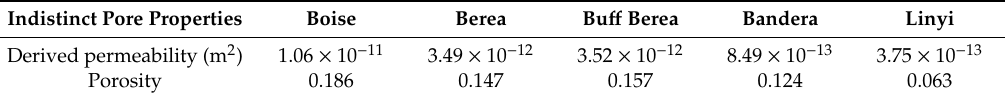
Table 5. Macroscopic parameters of Brinkman equation for the P indis domain